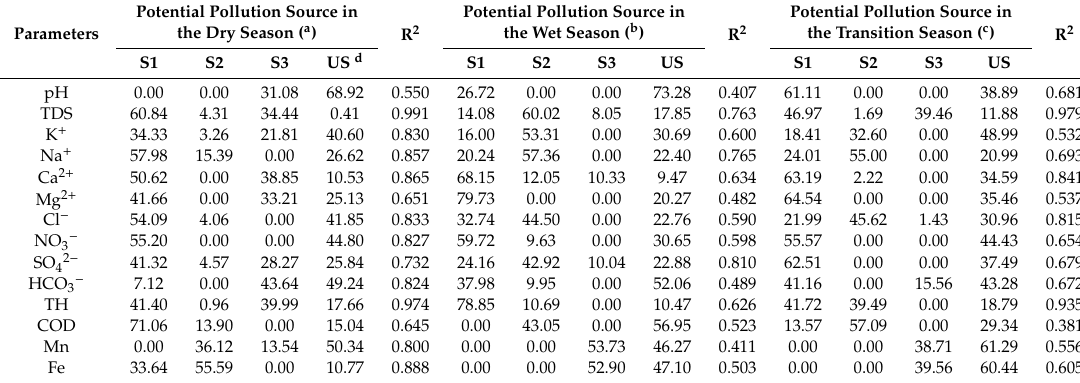
Table 4. Source contribution (in %) of each variable in three seasons in the Hutuo River alluvial-pluvial fan. Potential Pollution Source in the Dry Season ( a Parameters